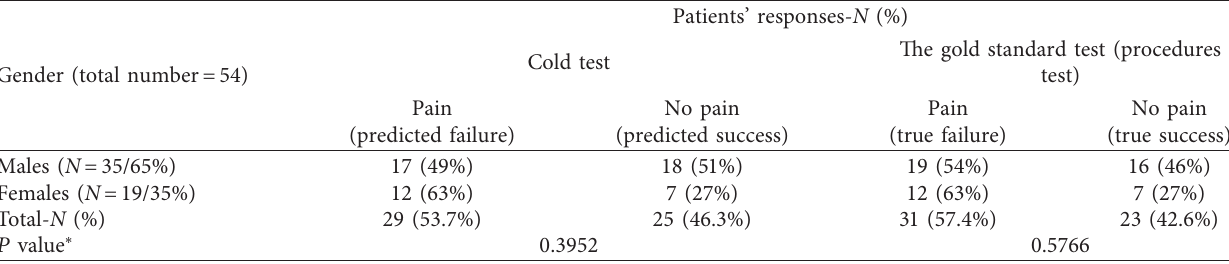
∗ Two-tailed Fisher exact test (difference P < 0 . Table 3: Statistical analysis of postanesthetic cold test results versus gold standard test results.